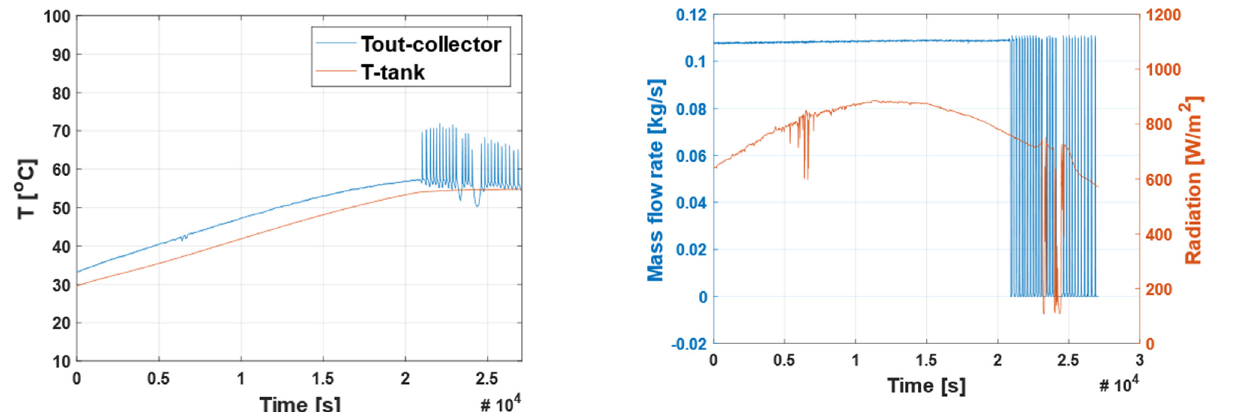
Figure 15. Measurement results of 12.06.